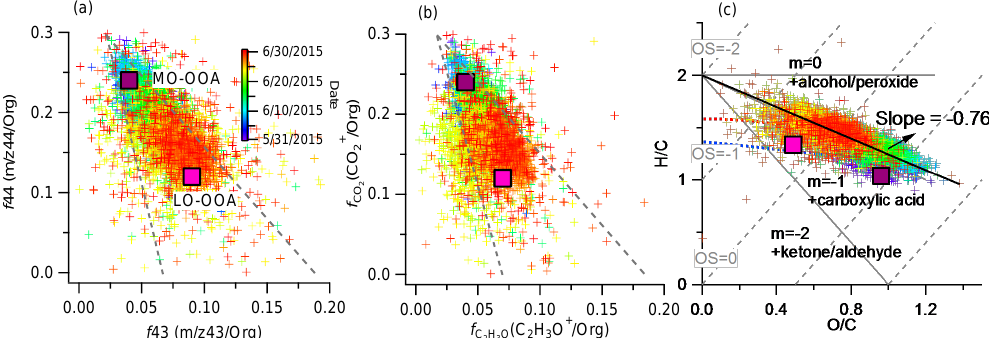
Figure 12. Scatter plots of (a) f 44 vs. f 43 (dates given in MM/DD/YYYY format), (b) f CO + the OA. The dashed lines in (a) and (b) refer to a triangular region that encompasses ambient OOA factors determined from PMF analyses of 43 AMS data sets (Ng et al., 2010). The light solid lines with slopes of 0, − 1, and − 2 in (c) indicate the changes of H / C against O / C due to adding specific functional groups to an aliphatic carbon (Heald et al., 2010); the light dashed lines indicate the oxidation state (OS) of − 2, − 1, 0, 1, and 2, respectively (Kroll et al., 2011); the red and blue dashed lines are derived from the right and left lines in the triangle plot; the heavy solid line indicates the slope of our measured data. The corresponding values of the OOAs identified in this study are also shown in each plot.